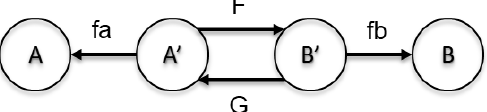
Figure 10. The structure of a binary consistency